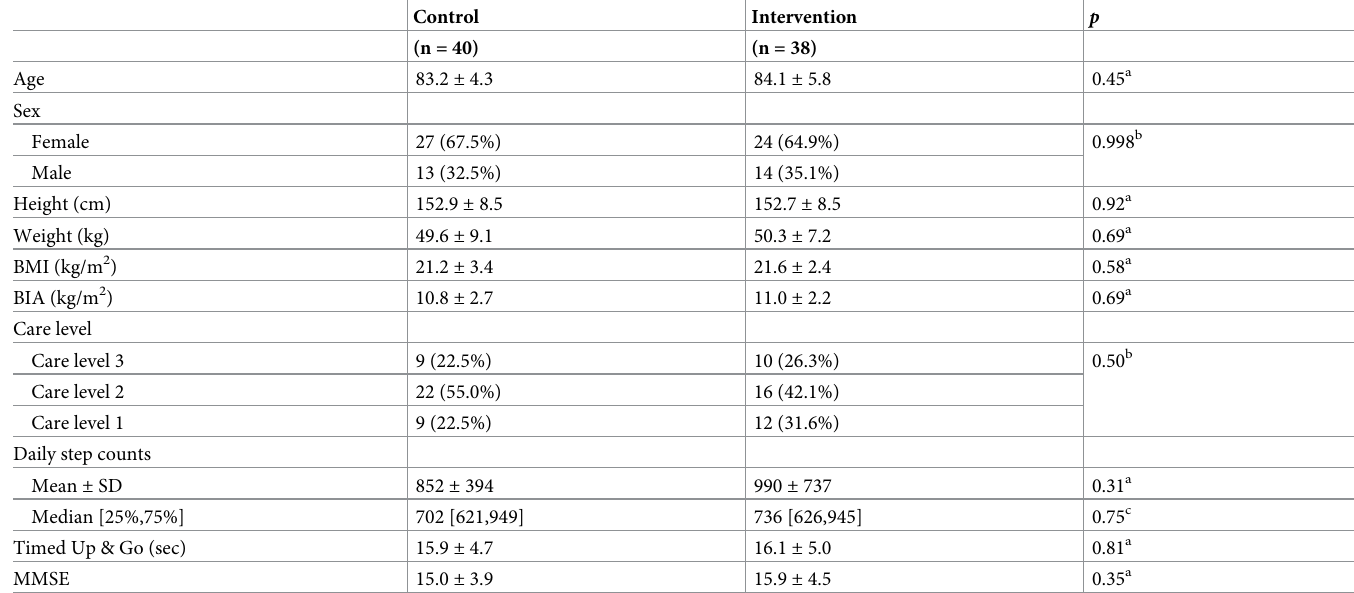
Table 1. Baseline